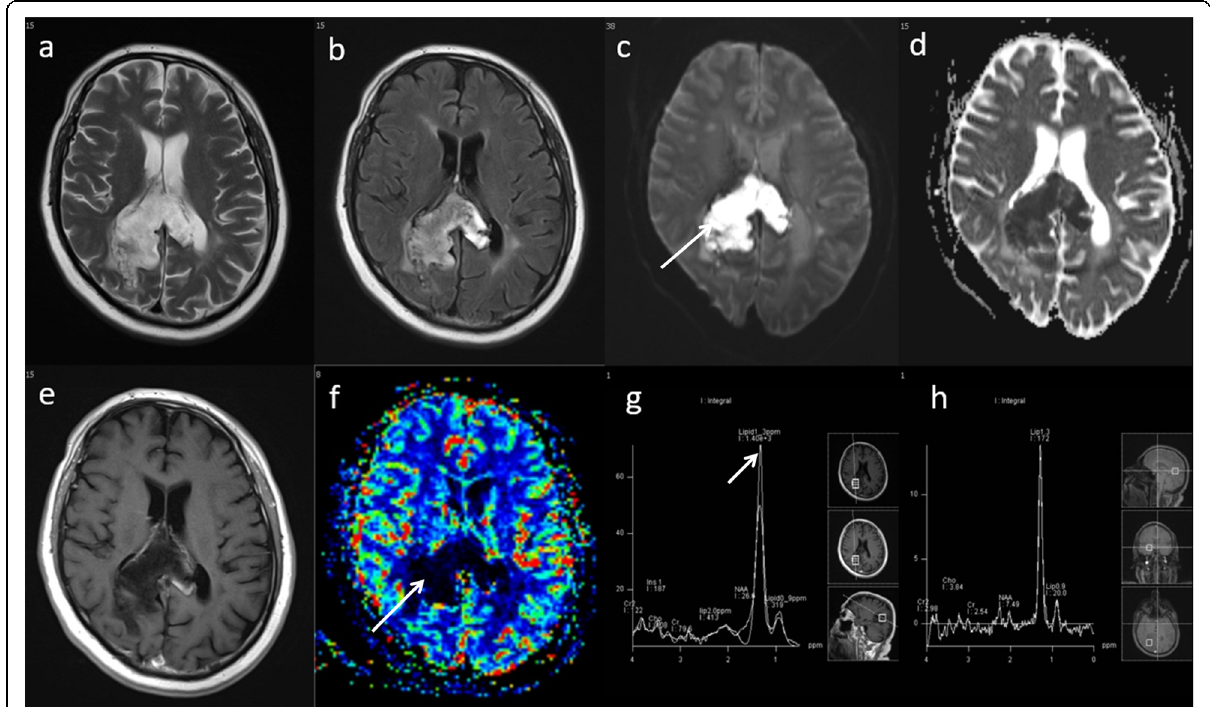
Fig. 17 Epidermoid-like lesion of the corpus callosum. Conventional MRI: a , b , e T2W, FLAIR and post-contrast T1W sequences show a lesion involving the splenium of the corpus callosum and right parietal lobe. Multiparametric MRI: c , d DWI and ADC images show restricted diffusion (arrow). f Very low perfusion on PWI (arrow). g MRS shows very high lipid (1.3 ppm, arrow), without an increase in choline. In this case, appearances are not typical for high-grade glioma as there is low perfusion and no significant increase in choline, and it is not typical